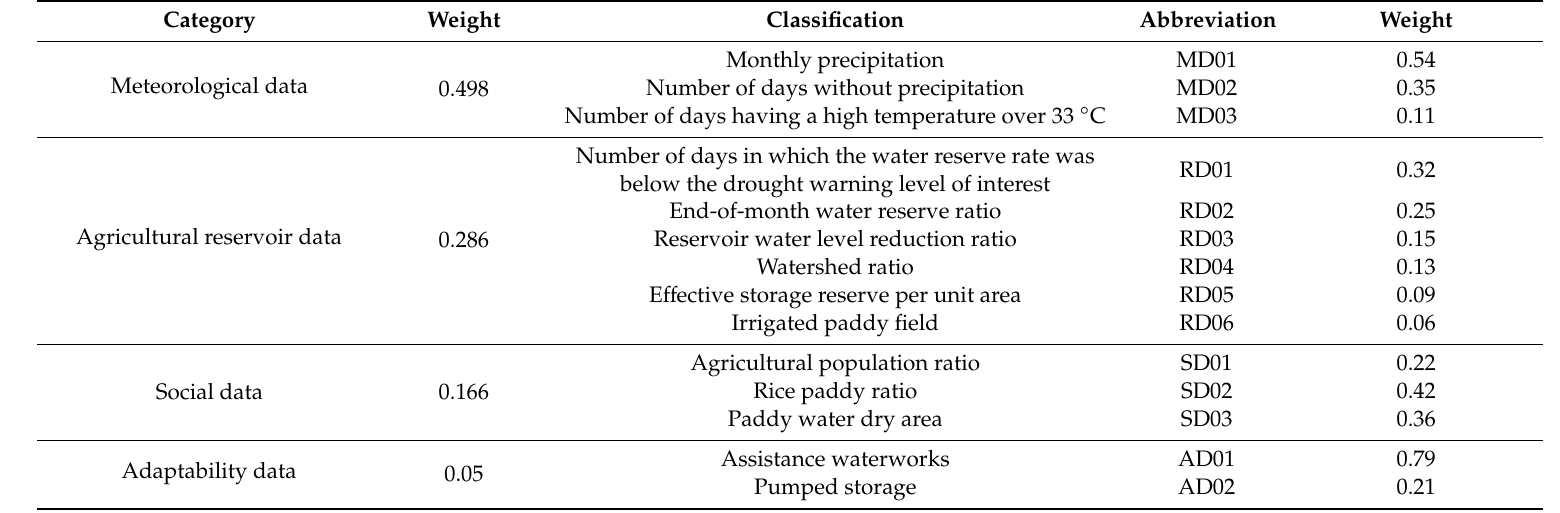
Table 5. Calculation of weights for each indicator through analytical hierarchy process